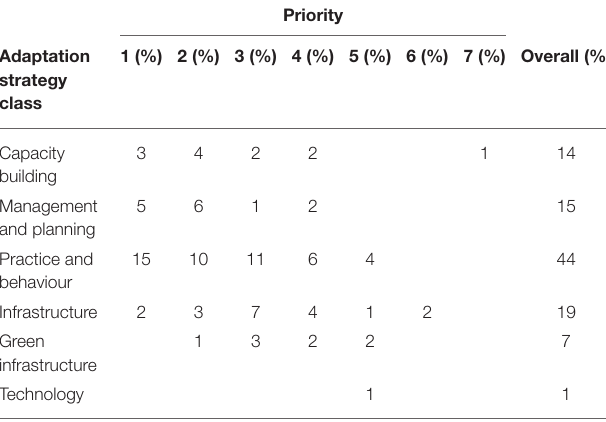
TABLE 3 | The 56 adaptation strategies’ occurrence ( n = 124) among the 31 villages in NTB and WNB, pooled into Biagini et al.’s (2014) classes.